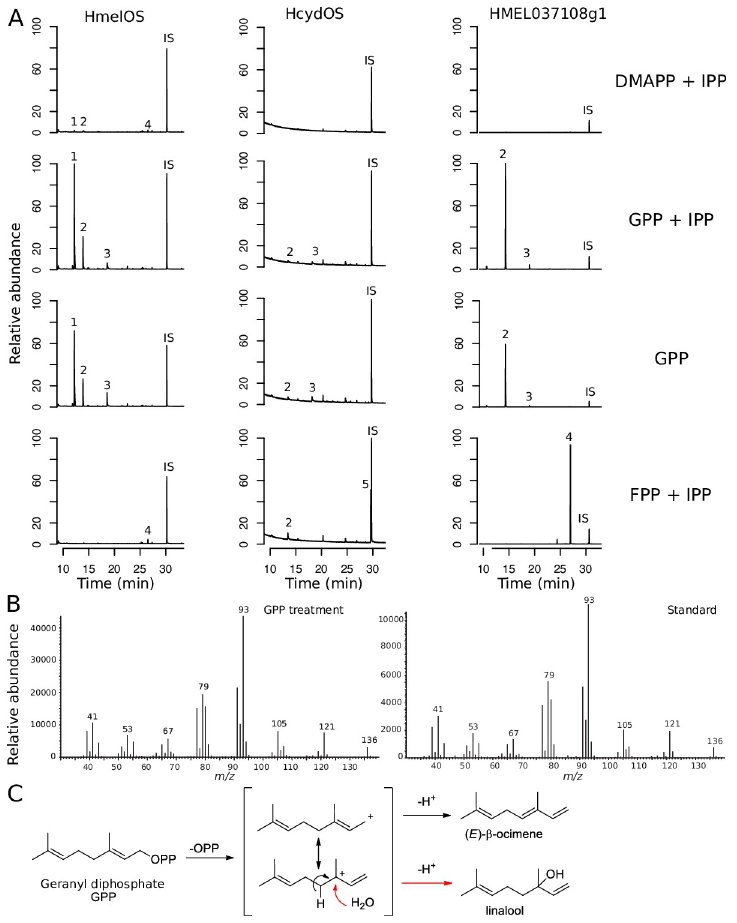
Fig 3. Functional characterisation of TPS activity of HmelOS and HMEL037108g1 from H . melpomene and HcydOS from H . cydno . (A) Total ion chromatograms of enzyme products in the presence of different